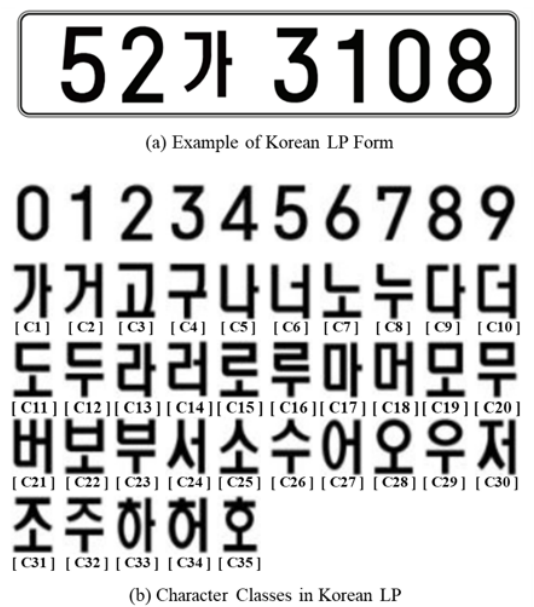
Figure 2. Korean LP form and character classes in Korean LP.